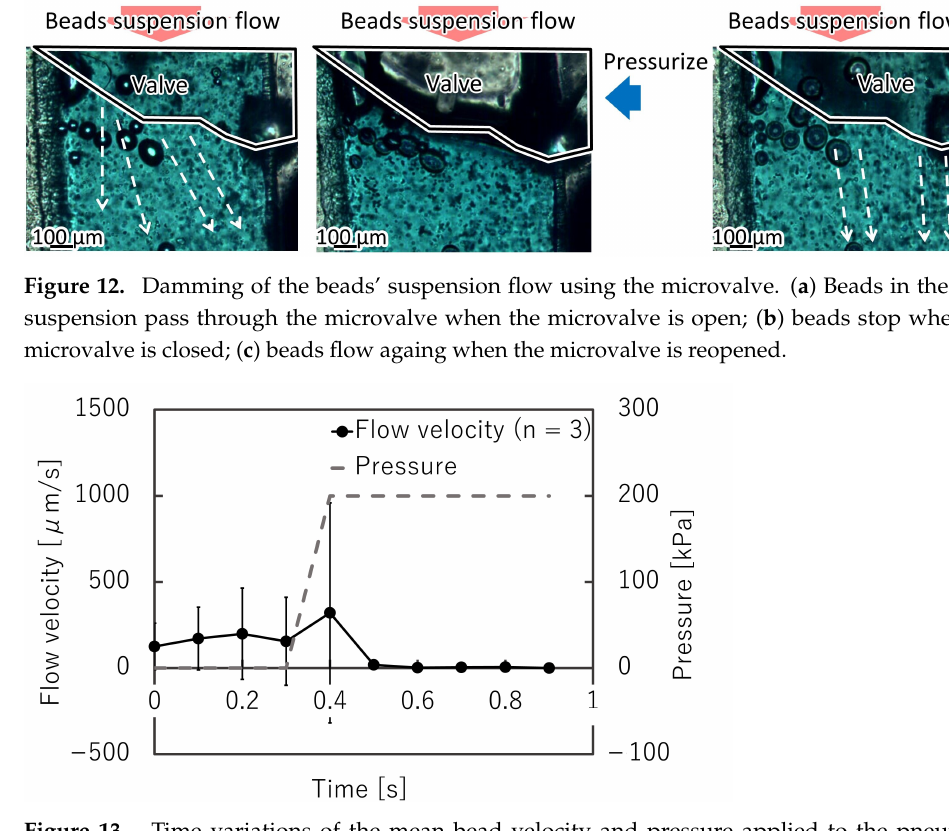
Figure 13. Time variations of the mean bead velocity and pressure applied to the pneumatic microchannel for the microvalve with a liquid microchannel height of 225 µ m ( n = 3).